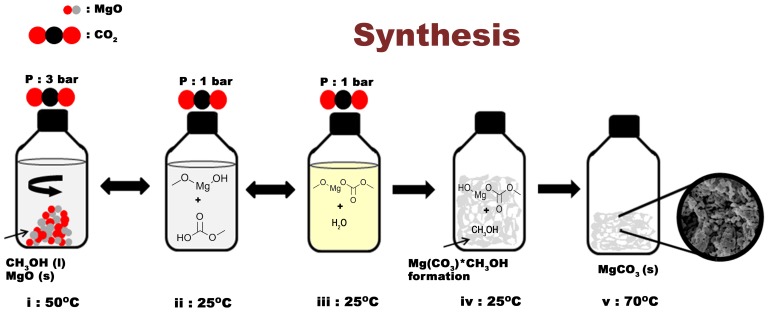
Synthesis of Upsalite.
i) In the first step MgO (s) is mixed with methanol under 3 bar CO2 pressure at 50°C. ii) After 2.5 h the HOMgOCH3 is formed in the solution, the pressure is lowered to 1 bar and the heating is turned off. At the same time the methanol reacts with the CO2 and forms CH3OCOOH (methyl hemicarbonic acid). iii) HOMgOCH3 reacts with CH3OCOOH and forms water and H3COCOOMgOCH3 (methyl esther of magnesium methyl carbonate). At this point the solution changes colour from white to light yellow. iv) H3COCOOMgOCH3 reacts with the water formed in step iii) and forms HOMgOCOOCH3 (or MgCO3·CH3OH) which upon v) heating at 70°C releases CH3OH and forms MgCO3.